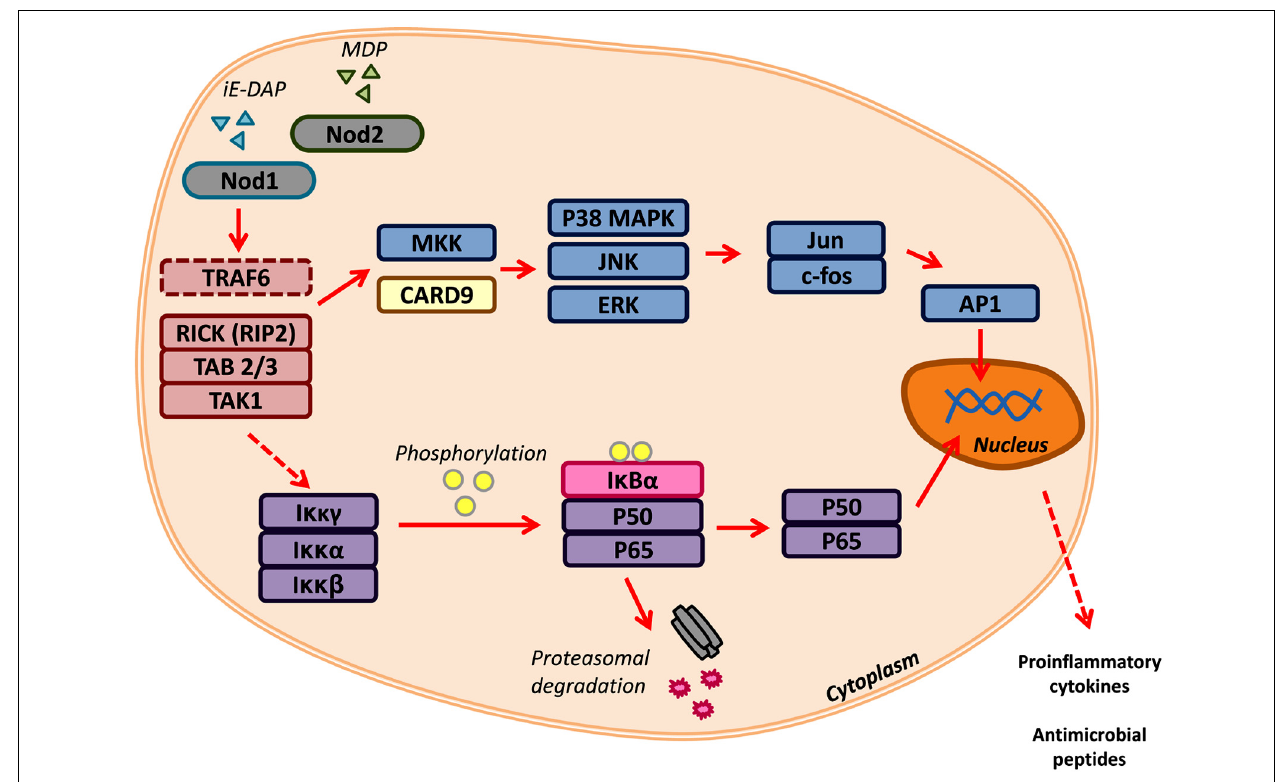
kinase and the (2) NF- κ B pathways. Transcription factors, such as AP1 and the NF- κ B complex (p50/p65), translocate to the nucleus to promote the transcription of pro-inflammatory cytokines and antimicrobial